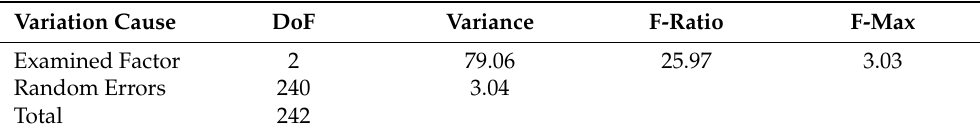
Table A1. ANOVA results of the effect of all process technologies on Ra y . Variation Cause DoF Variance F-Ratio F-Max Examined Factor 2 Random